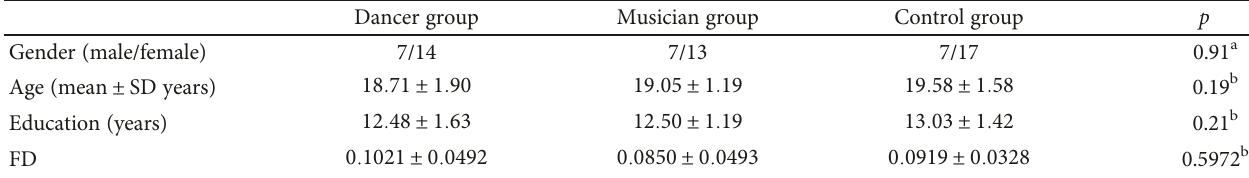
Table 1: Participant demographic information.